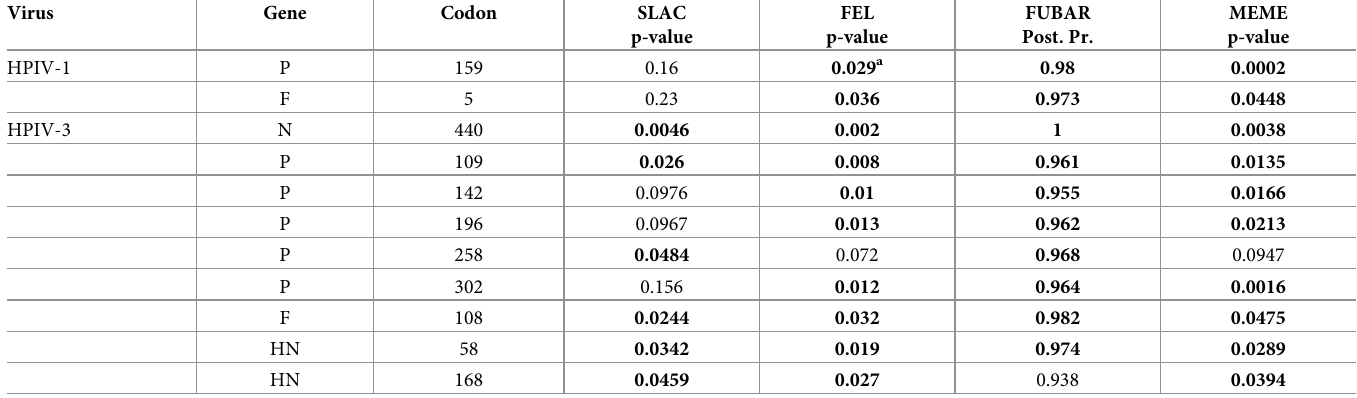
Table 1. Sites under positive selection for HPIV-1 and